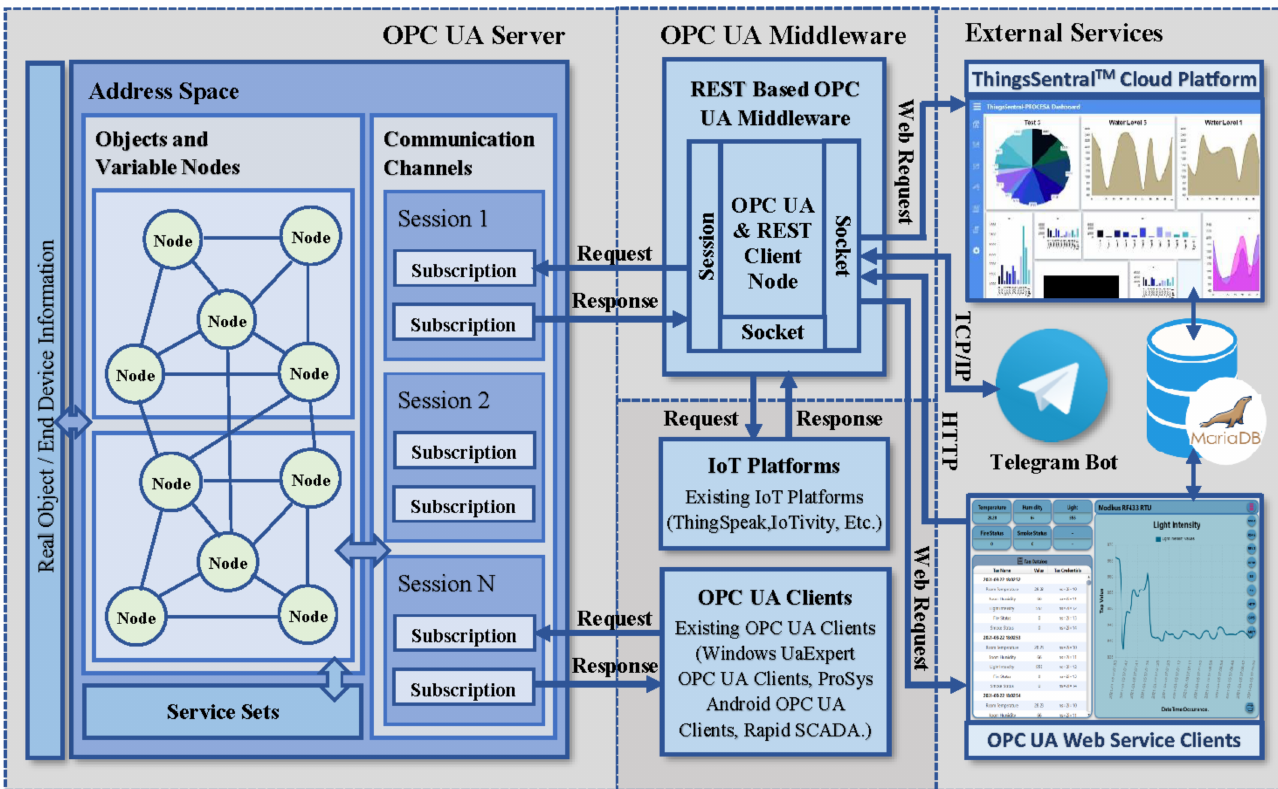
Figure 1. Architectural framework of the proposed